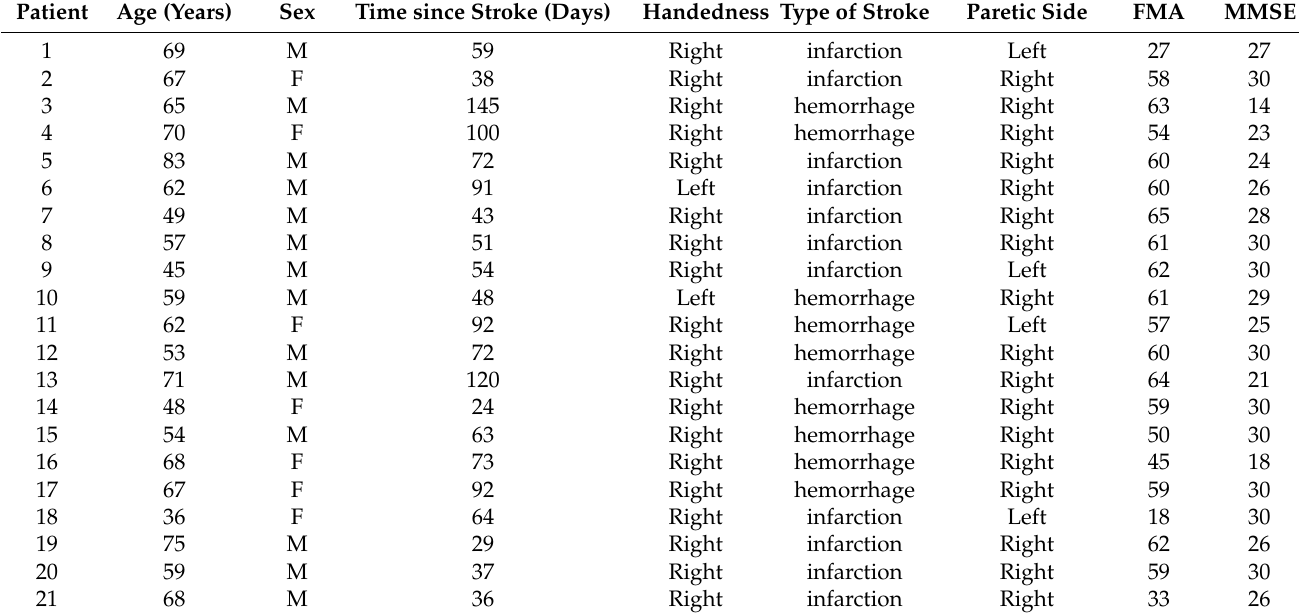
Table 1. Clinical characteristic of stroke